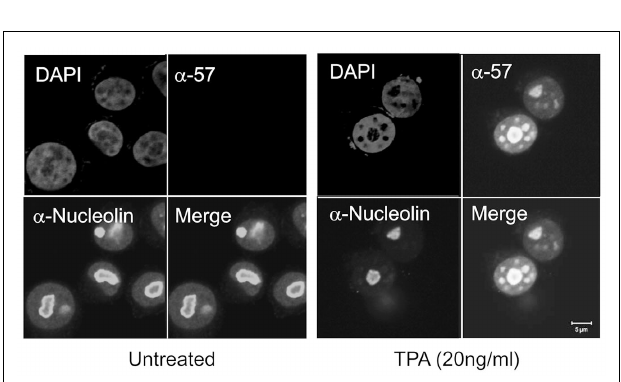
FIGURE 2 | Cellular localization of KSHV ORF57. BCBL-1 cells were reactivated withTPA to express the lytic KSHV genes. Cells were fixed and permeabilized and proteins immunostained using an ORF57-specific antibody and a monoclonal antibody to C23 and FITC andTexas Red secondary antibodies. ORF57 can be seen localizing in the nucleus, as well as the nuclear speckles and colocalizing in the nucleolus with